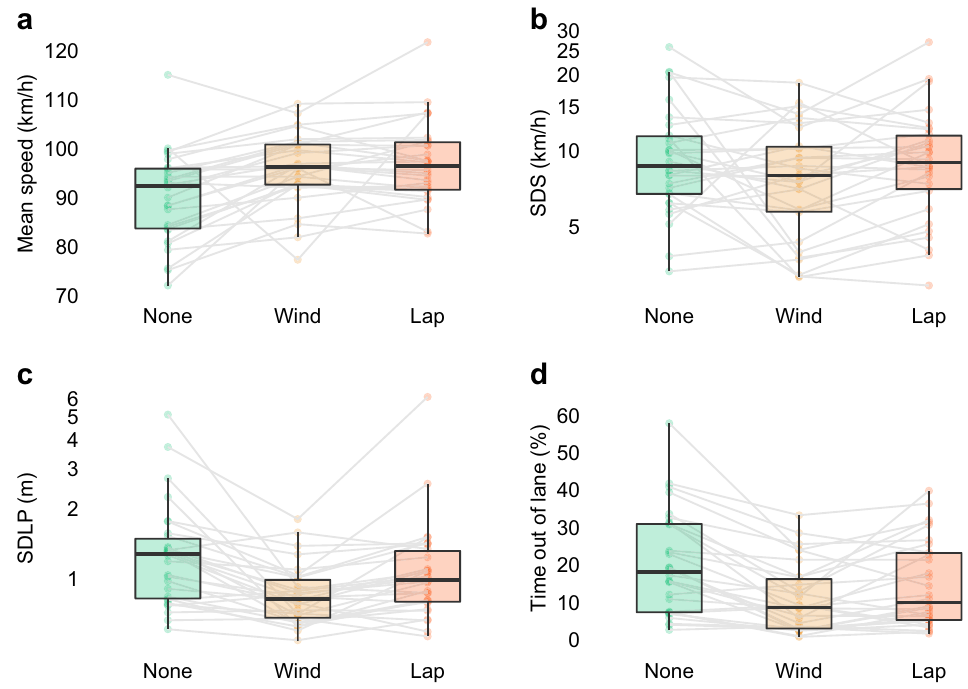
Figure 3. Comparison of driving behaviour when a cellphone was present (in either the Wind(ow) or Lap position) or absent. Outcome measures include ( a ) mean speed, ( b ) standard deviation of speed (SDS), ( c ) standard deviation of lane position (SDLP), and ( d ) proportion of time during the trial where any part of the vehicle was on or outside the correct lane markings. Trials where the cellphone was present were associated with faster driving, a lower SDLP, and less time spent out of lane position. Compared with having the cellphone on the windscreen, having the cellphone in the lap resulted in a higher variation in lane position and an increased amount of time with the vehicle out of the correct lane on the